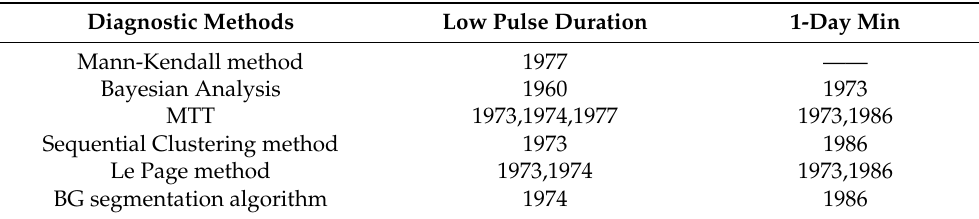
Table 6. Diagnostic results of the strong variation index and corresponding mutation year.